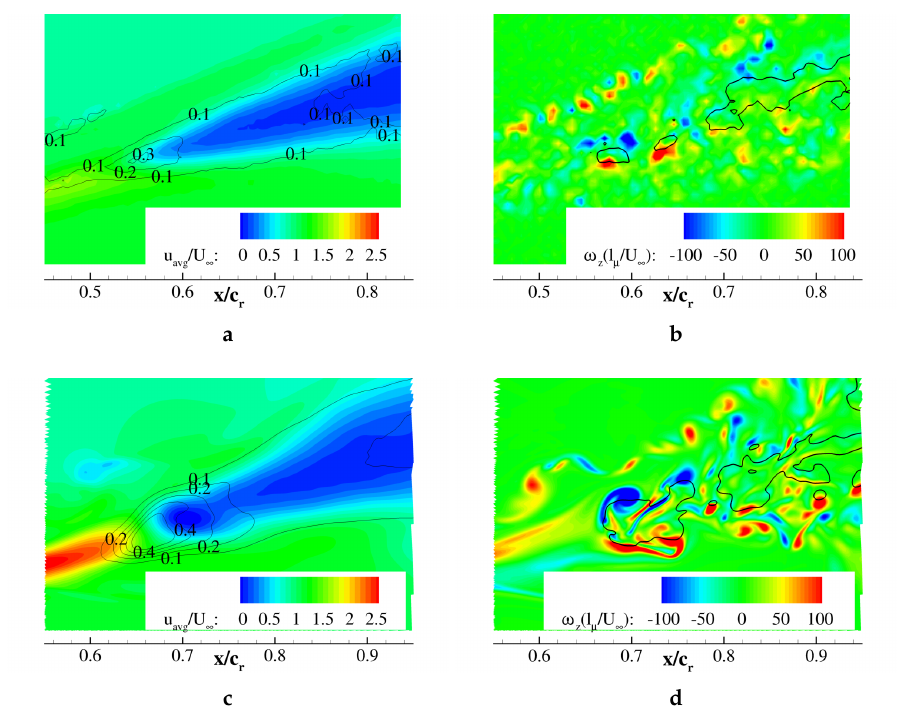
Figure 5. Plane along the vortex core, α = 23 ◦ , Re = 1.0 × 10 6 : ( a ) measured and ( c ) computed averaged axial velocity with k / U 2 ∞ isolines; ( b ) measured and ( d ) computed instantaneous in-plane vorticity with isolines representing u = 0. DES views ( c , d ) shifted by 0.1 in the relative chordwise and spanwise direction.